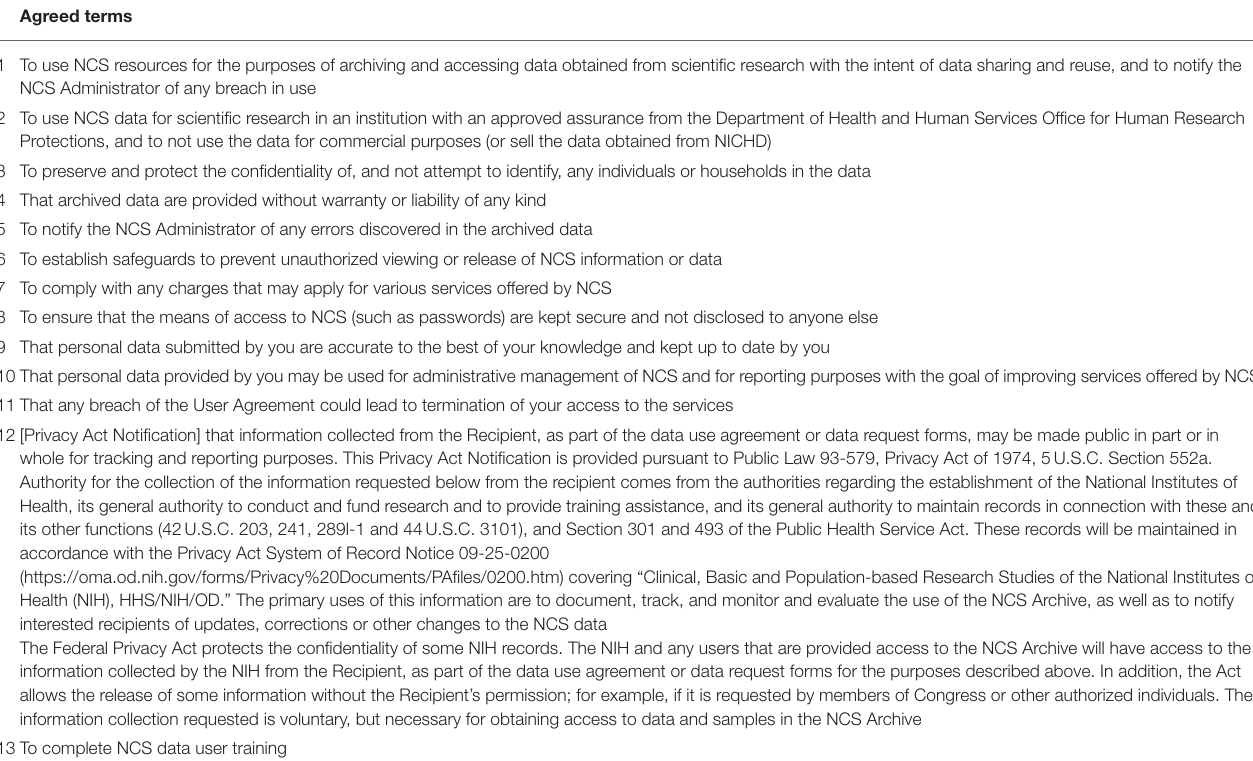
TABLE 3 | NCS data use agreement terms.